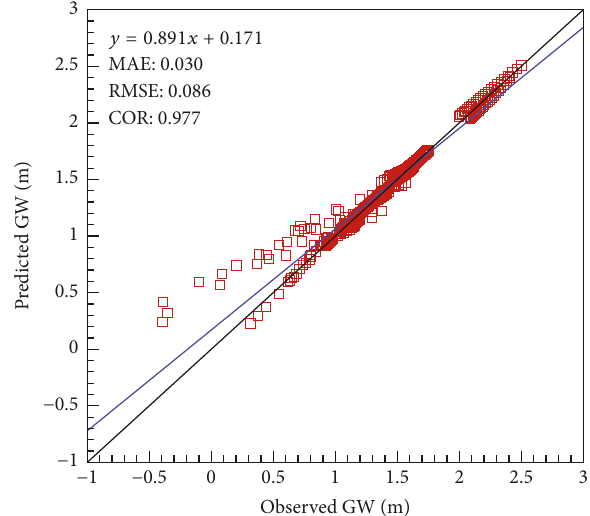
Figure 10: Scatter plot of the predicted groundwater levels of the optimal estimated heterogeneous 𝛼 field and the observed groundwater levels of the reference 𝛼 field in the synthetic